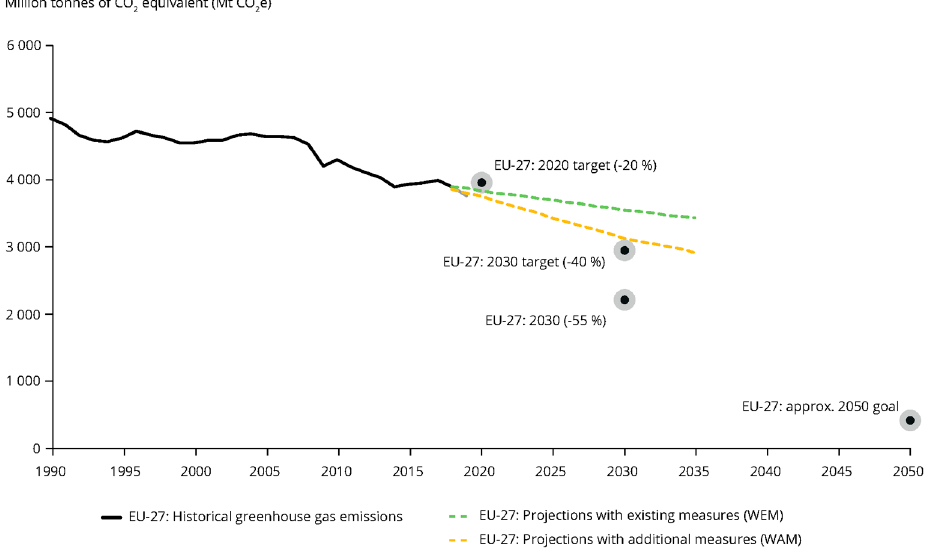
Figure 1. Greenhouse gas emission targets and trends for the EU-28 Member States (EU-28 and after 2020 EU-27) according to MMR (Monitoring Mechanism Regulation)projections (million tonnes of CO 2 ). Source: European Environment Agency (EEA) (2020).